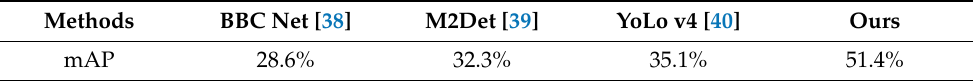
Table 3. The comparison between the proposed method and object detection methods. Methods